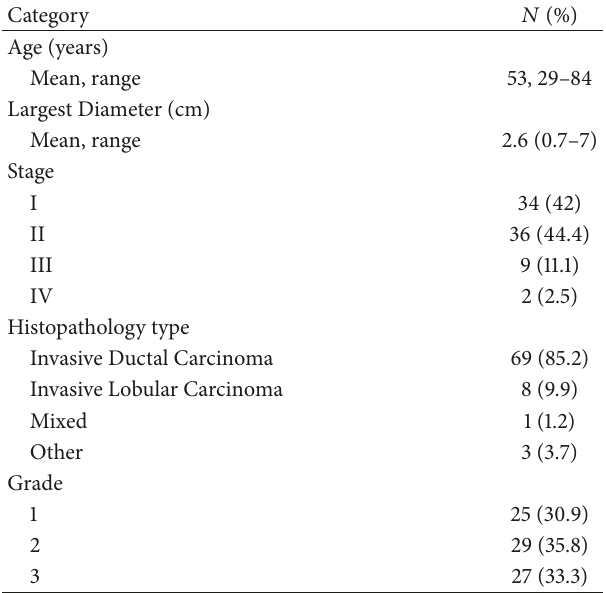
Table 1: Clinical demographic